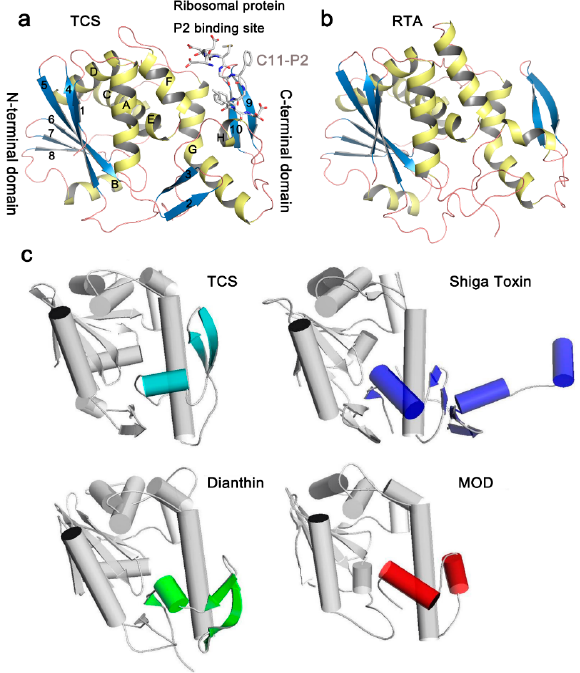
Figure 2. Representative structures and fold of RIPs. ( a ) Structure of TCS complexed with a C-terminal 11aa fragment of the ribosomal P protein (PDB code: 2JDL). The conserved secondary elements are labeled individually. α -Helices are colored yellow, β -strands are colored blue and loops are colored pink. The last 11 residues of ribosomal stalk protein P2 (C11-P2) are shown as gray sticks; ( b ) The structure of the catalytic chain A of Ricin (RTA); ( c ) Structural comparison of selected RIPs with TCS. The C -terminal domain of TCS is colored light blue. Differences in the structural features compared to TCS are highlighted in the RIP. It is found that the N -terminal domains are more conserved among the RIPs.